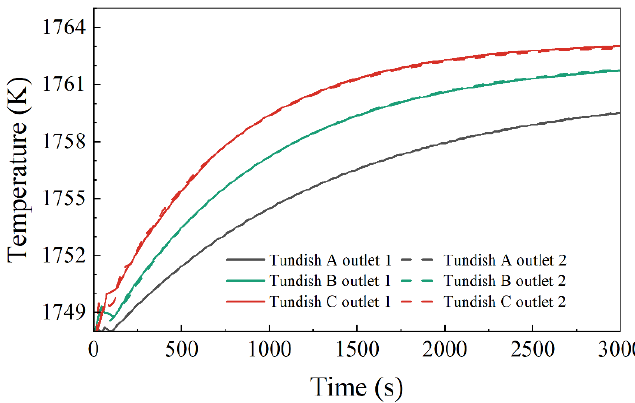
Figure 13. Temperature variation of molten steel at tundish outlets.